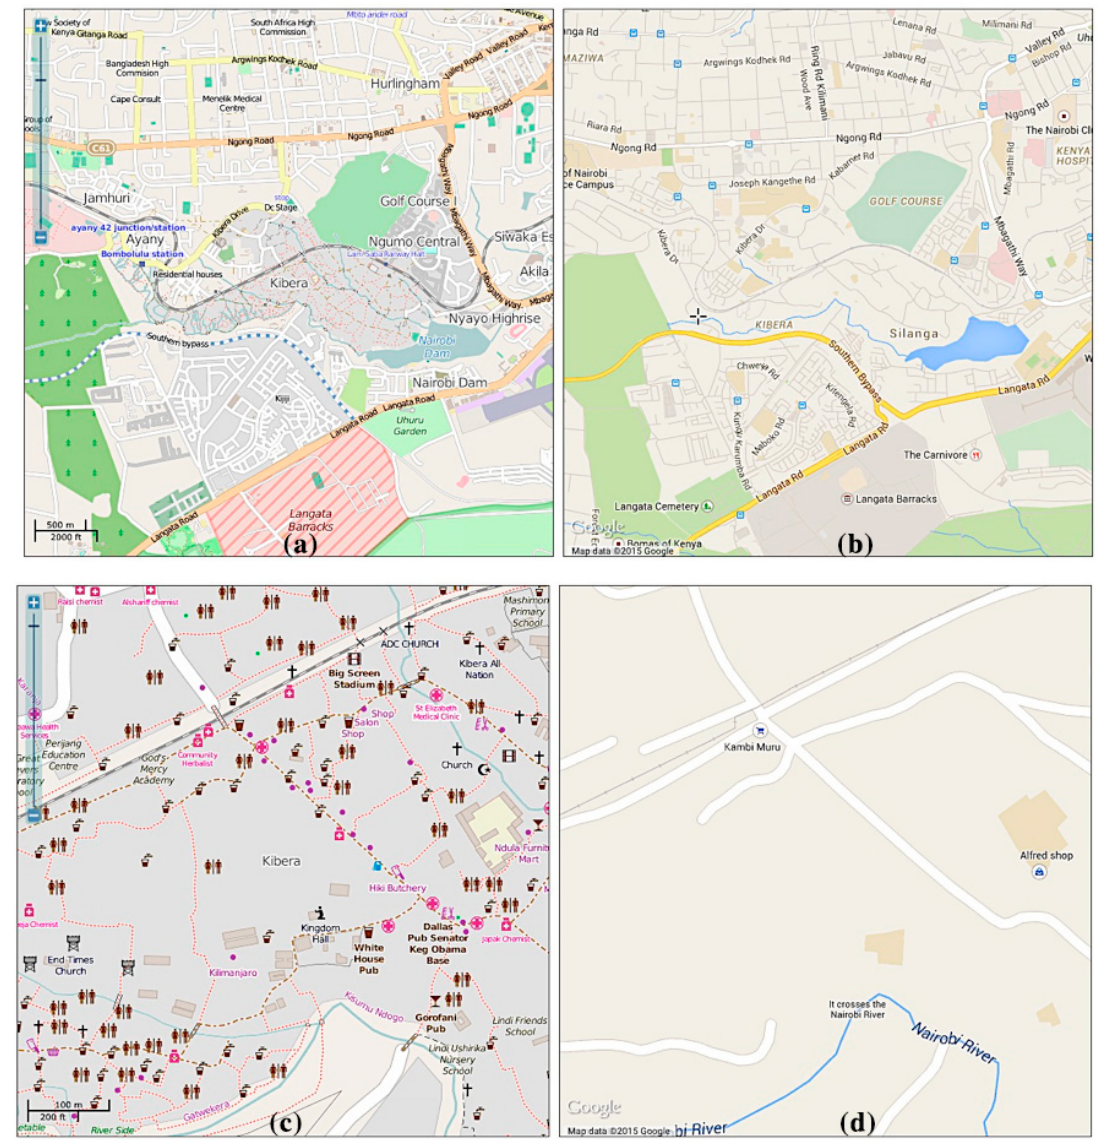
Figure 7. OSM and Google Maps views of Kibera slum [193] Top images (overview of Kibera): ( a ) left OSM and ( b ) right Google Maps; Bottom images (zoomed in view of Kibera): ( c ) left OSM and ( d ) right Google Maps.